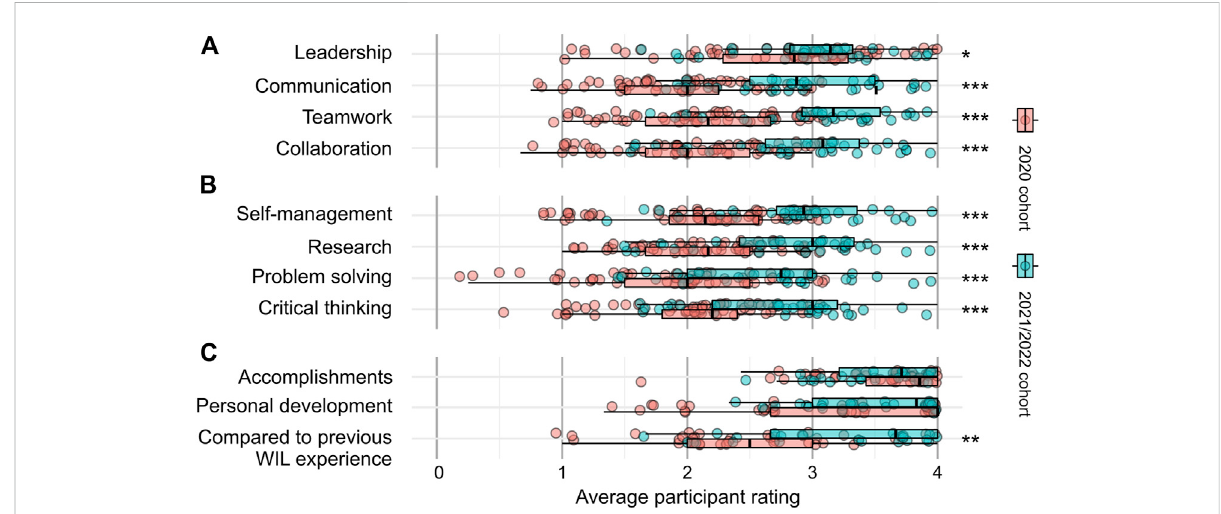
FIGURE 5 Program improvements. Response distributions grouped by participants from the fi rst iteration of the program (2020 cohort) and participants from later iterations (2021/2022 cohort) grouped by (A) interpersonal skills, (B) cognitive and intrapersonal skills, and (C) personal experiences. Asterisks indicate the upper value of the p -value associated with the null hypothesis that the two distributions are not shifted relative to one another (Two-sample Wilcox test, one-sided). One asterisk corresponds to p < 0.05, two asterisks correspond to p < 0.002, and three asterisks correspond to p <